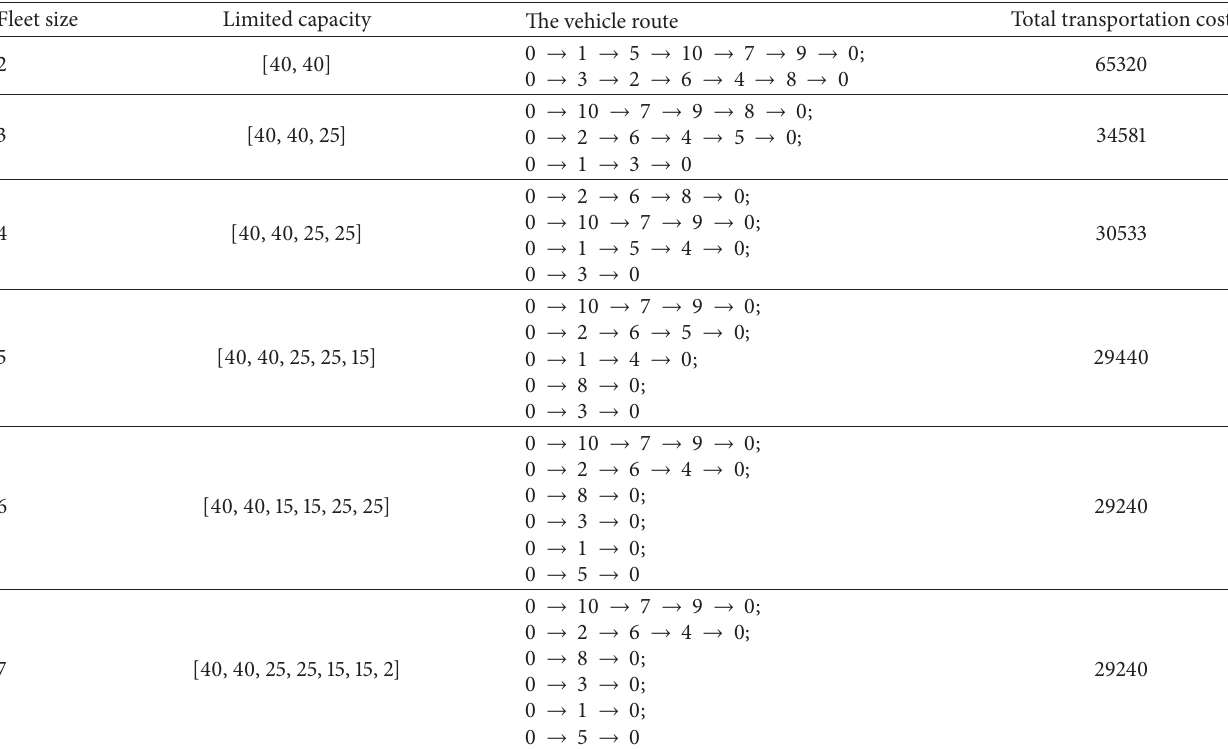
Table 5: The results with time-window constraints.